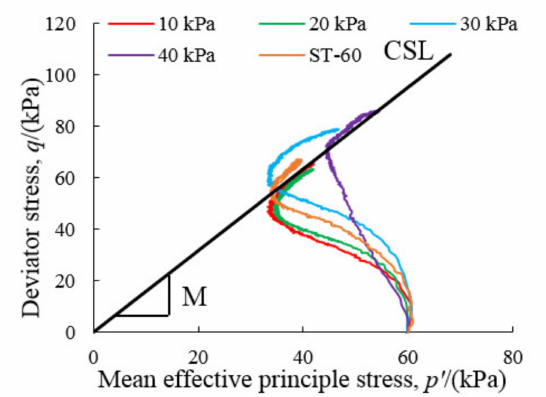
Figure 13. Effective stress paths of the soft soil at various cyclic stress ratios ( n = 1000, p (cid:48) 0 = 60 kPa, U r = 100%).